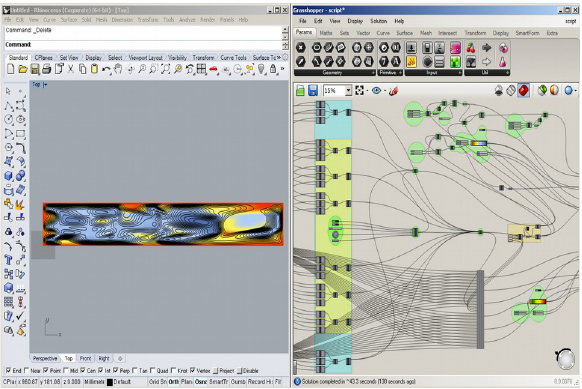
Figure 8. Processing of data within the plugin Grasshopper inside Rhinoceros (R.